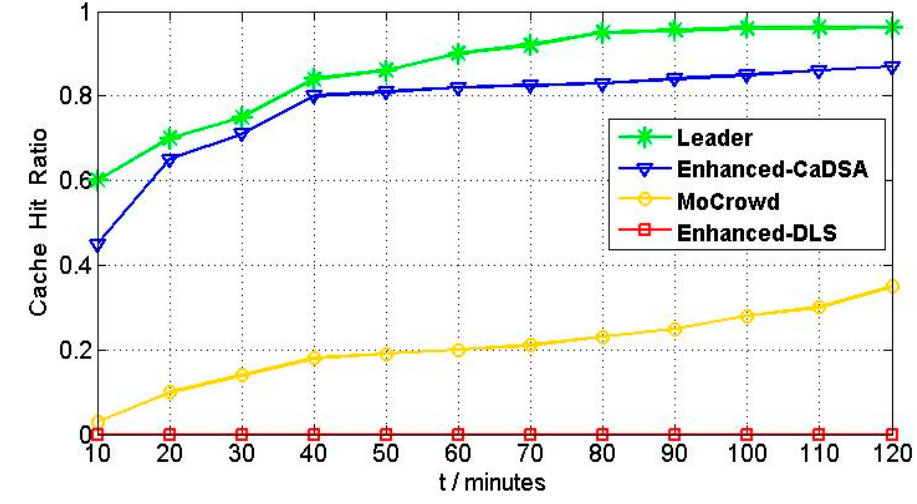
Figure 14. Cache hit ratio vs. time progress, p=100.